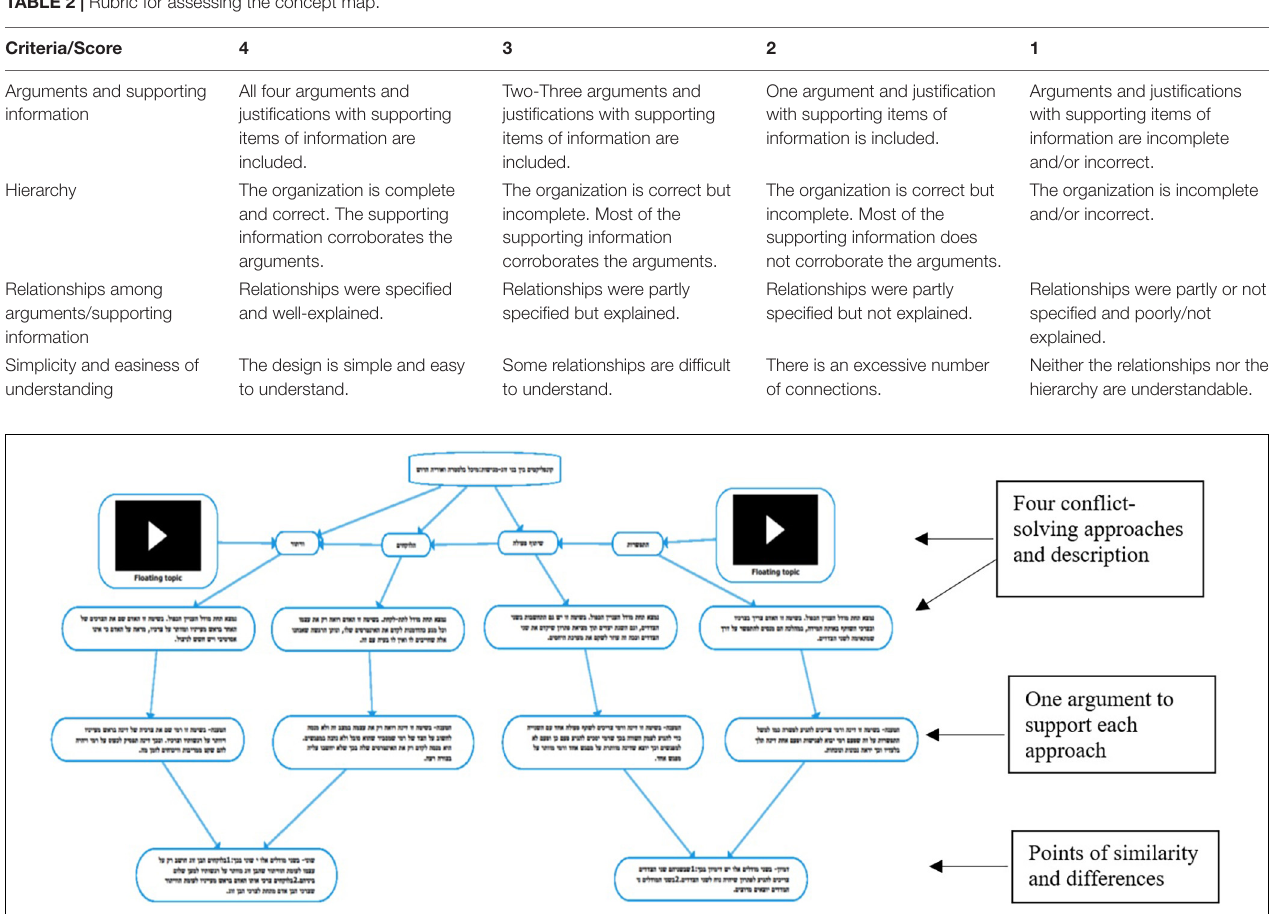
TABLE 2 | Rubric for assessing the concept map.